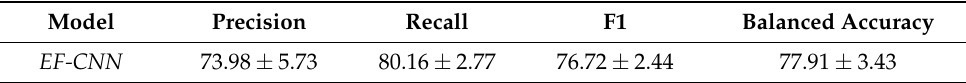
Figure 7. ( Left ) ROC curves of the five models trained with the cross validation technique for the classification task. The inset plot shows the ROC curves with logarithmic scale for the x -axis. ( Right ) Confusion matrix obtained with the classification approach. The best result achieved with the k-fold cross validation technique is shown for EF-CNN. Rows are true unchanged (TU) and true changed (TC) classes (ground truths), whereas on columns are predicted unchanged (PU) and predicted changed (PC) classes (inference results). Table 4. Average percentage values of the considered metrics for the classification task. Uncertainties are calculated as the standard deviations over the five models trained with the k-fold cross